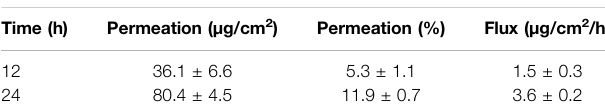
TABLE 4 | OXB skin permeation results (mean ± SD, n =